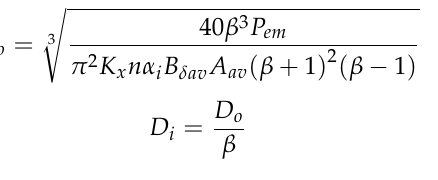
Table 1. Design Parameters of AFPMBLDCM.